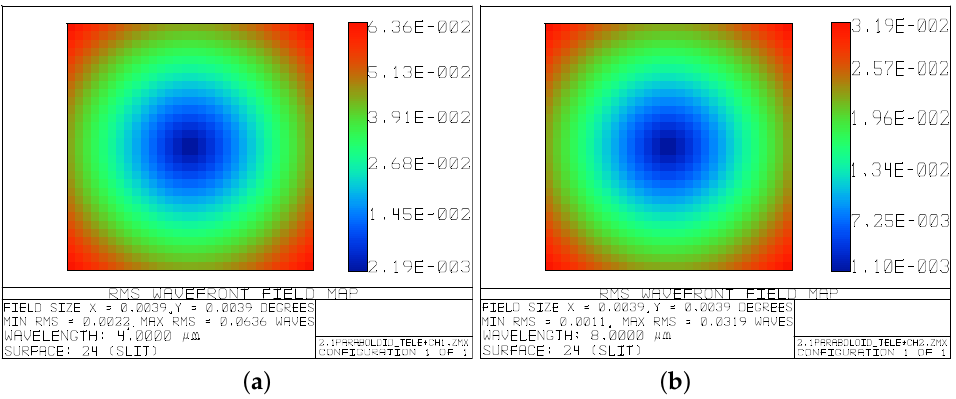
Figure 7. Root-mean-square (RMS) wavefront error (WFE) maps over full FOV at exit of dichroic system for ( a ) CH1 and ( b )